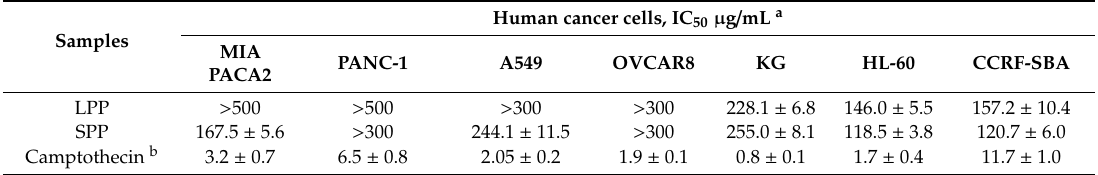
Table 2. Cytotoxic activity of isolated compounds on human cancer cell lines.